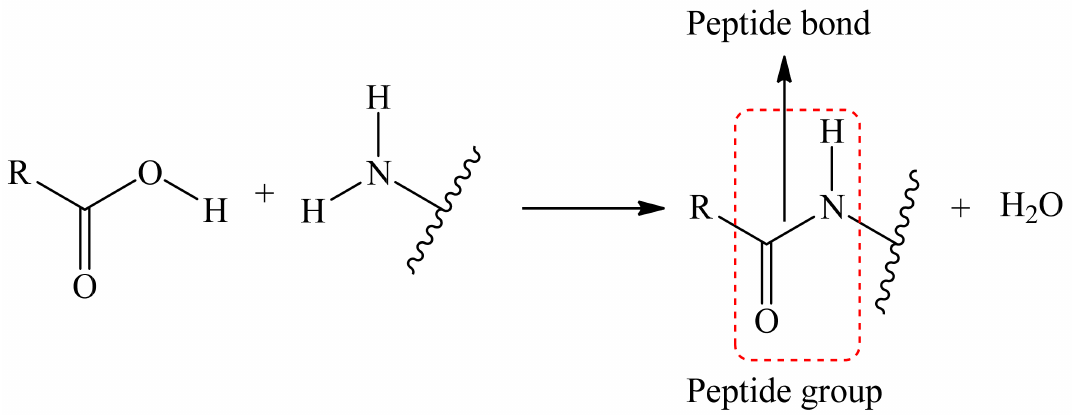
Figure 3. Scheme of the peptide bonding process.